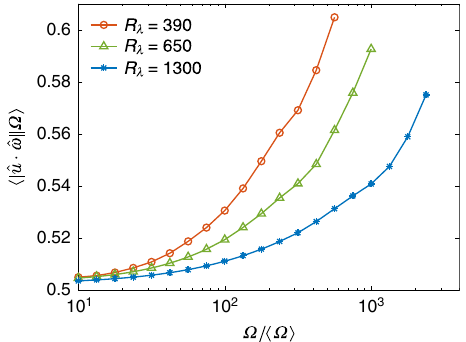
Fig. 3 Preferential alignment of vorticity and velocity in regions of intense vorticity. Averaged absolute value of the cosine between velocity and vorticity vectors, conditioned on enstrophy relative to its mean value, at Taylor-scale Reynolds numbers R λ = 390 – 1300.